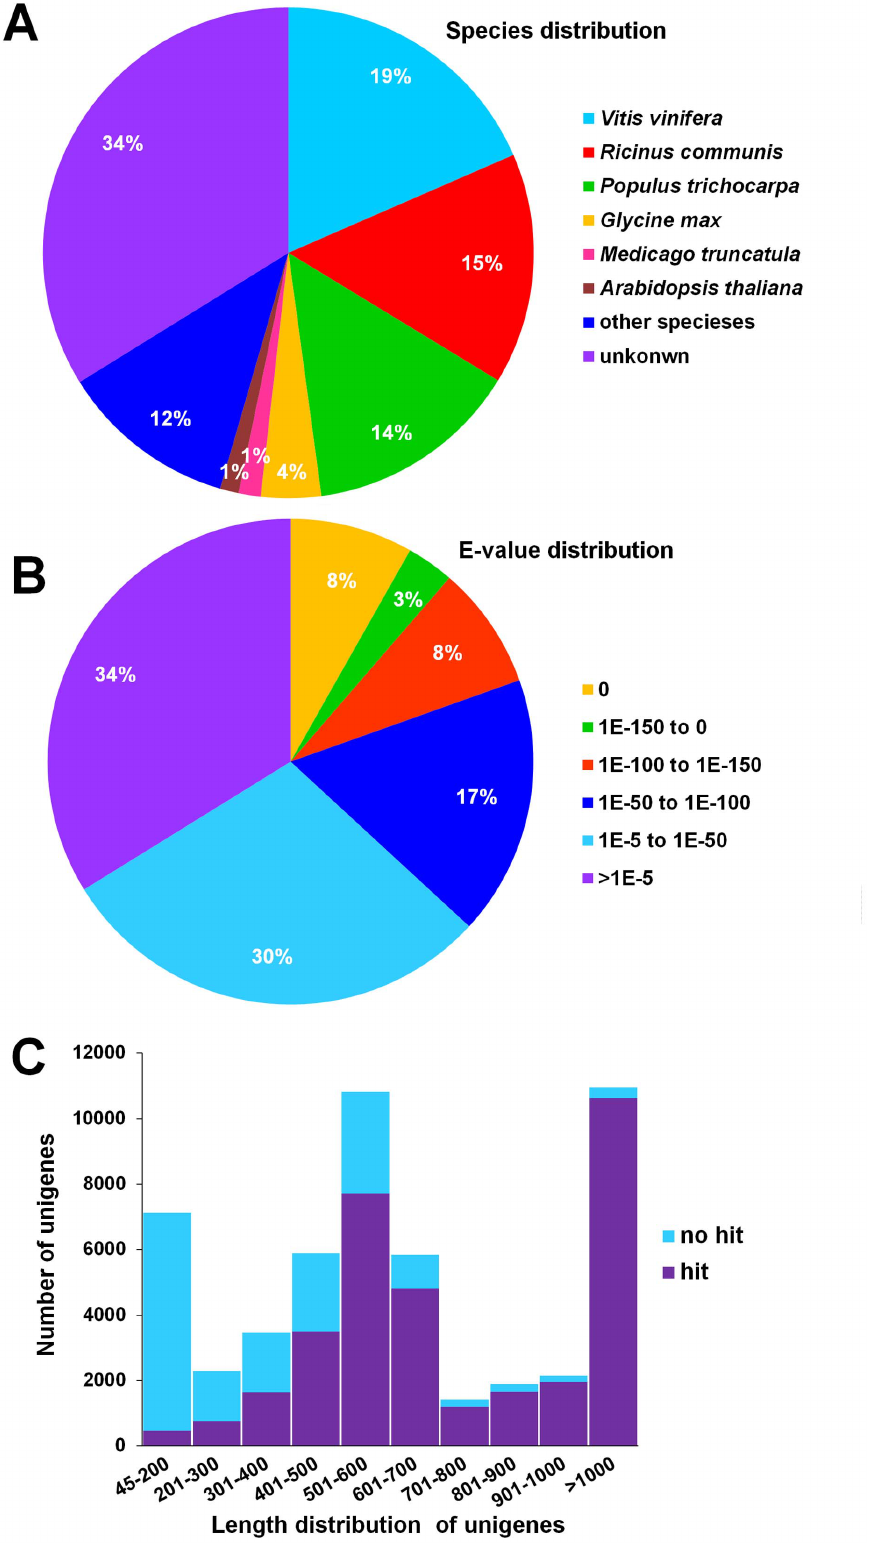
Figure 1. Unigenes functional annotation results. (A) Top-hit species distribution for BLASTx matches for yellow horn unigenes using the following order of priority: NR, TrEMBL and Swiss-Prot. (B) E-value distribution of top BLASTx hits for each unigene. (C) Distribution of unigenes in length with BLASTx hits compared with those without hits.